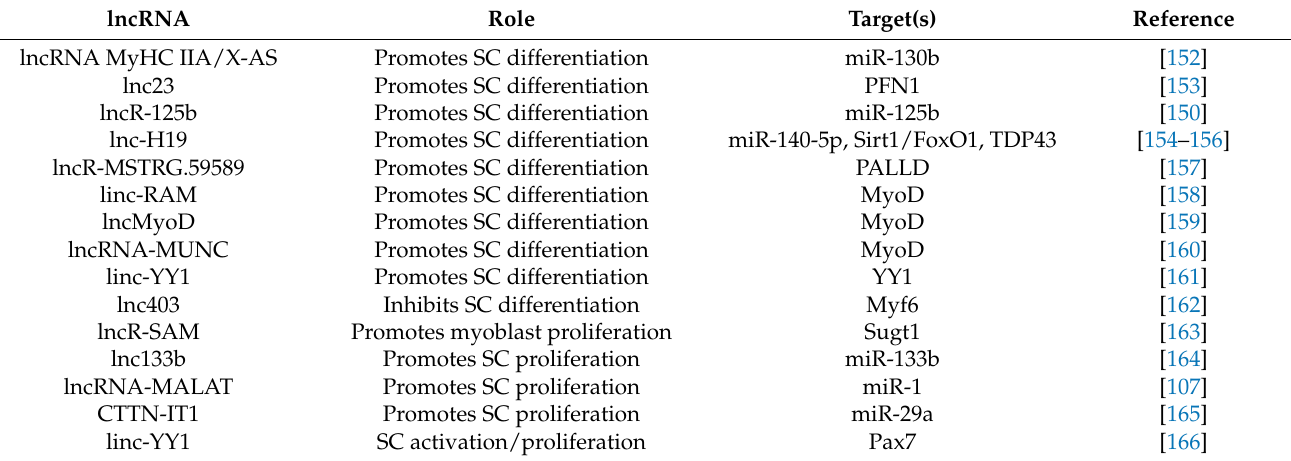
Table 6. Long noncoding RNA in myogenesis